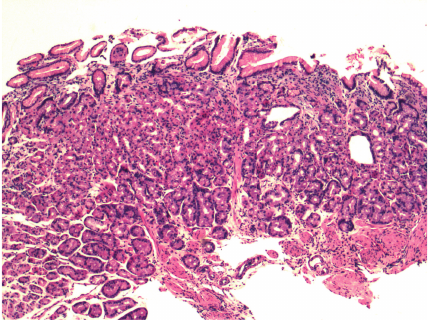
Figure 4: Mild chronic gastritis and reduction of fundic gland polyps, Hematoxylin and Eosin stain, 40x